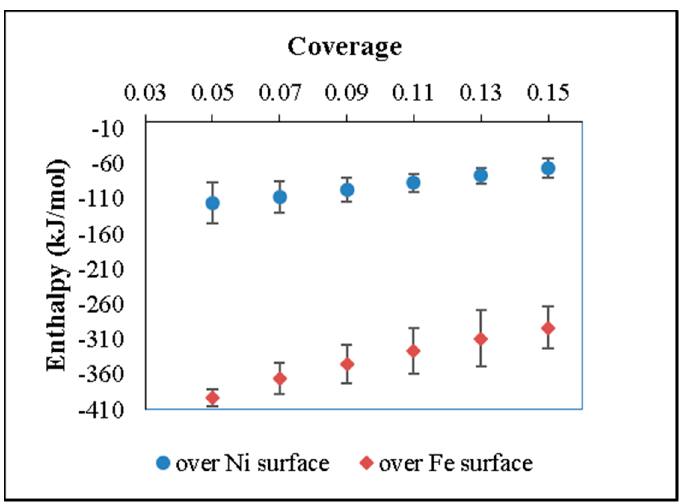
Figure 12. Variation of Enthalpy of ammonia adsorption with coverage of ammonia over metals surfaces.